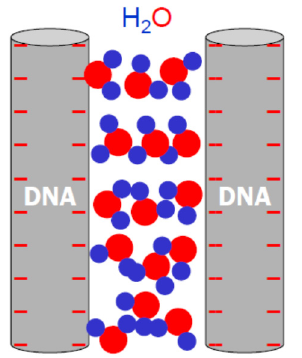
Figure 5. A cartoon illustration of DNA–DNA interactions in a side-by-side